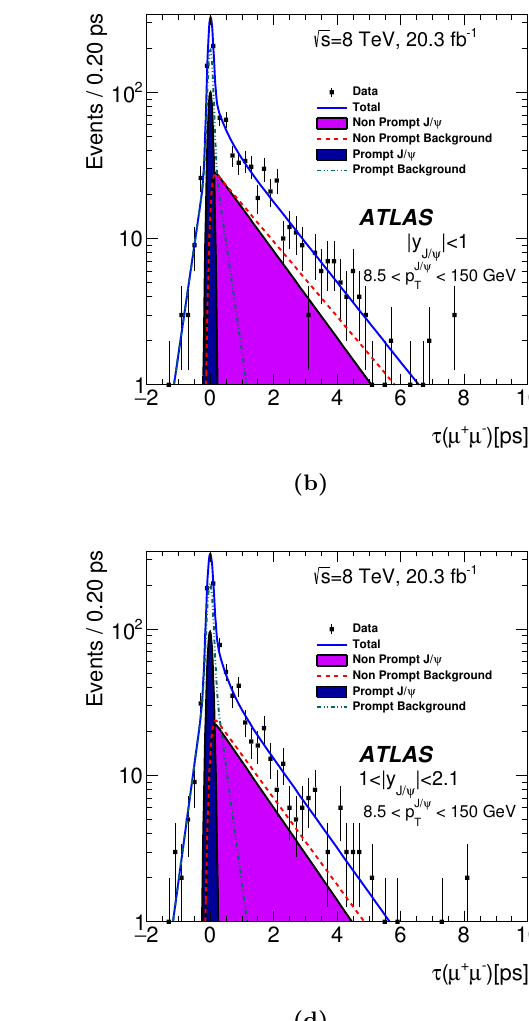
< 150 GeV; (c) J= candidate mass and (d) pseudo proper T j < 2 : 1 and p T range 8 : 5 < p J= J=